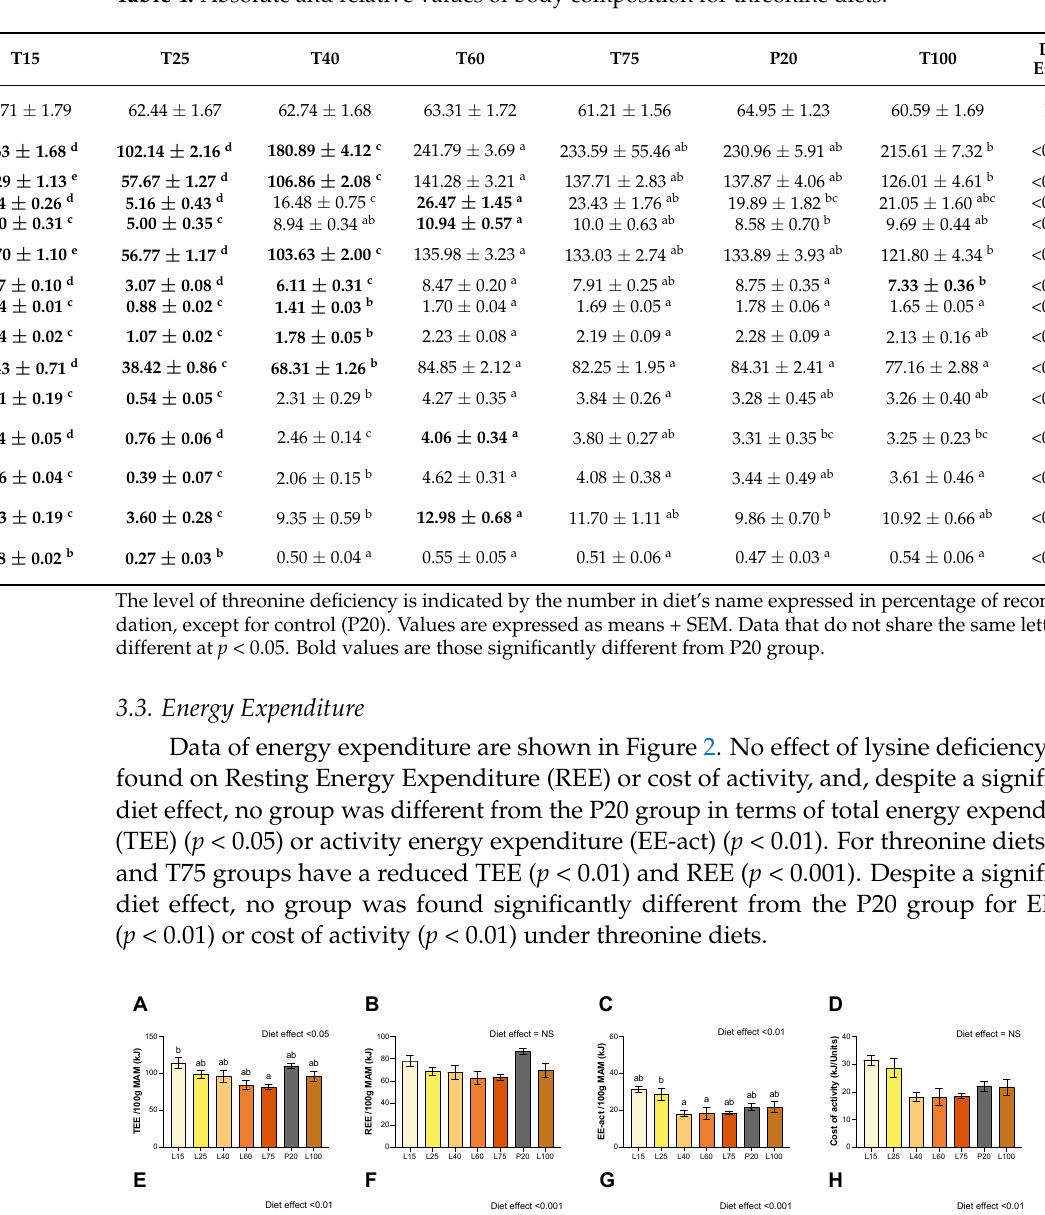
Table 4. Absolute and relative values of body composition for threonine diets.